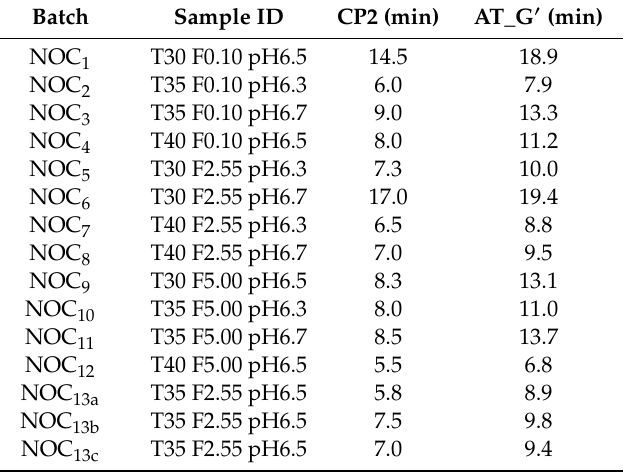
Table 2. Milk renneting: comparison of time corresponding to the maximum value of the second MCR-ALS concentration profile calculated from FT-NIR data (CP2) and time corresponding to acceleration in elastic modulus (G (cid:48) ) increase extrapolated from time curing curves (AT_G (cid:48) ). Batch